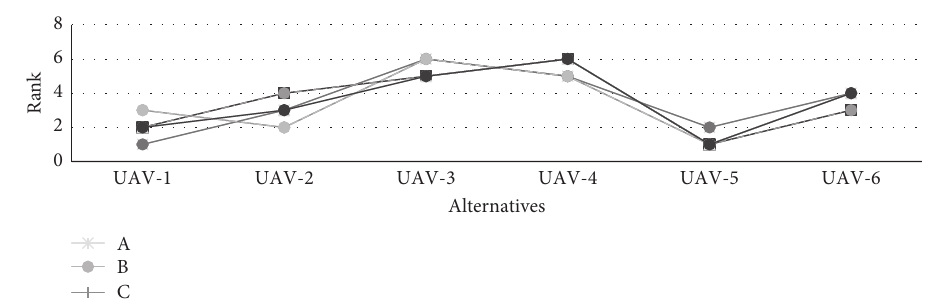
Figure 4: Comparison of ranking approaches. Table 9: Spearman’s rank correlation